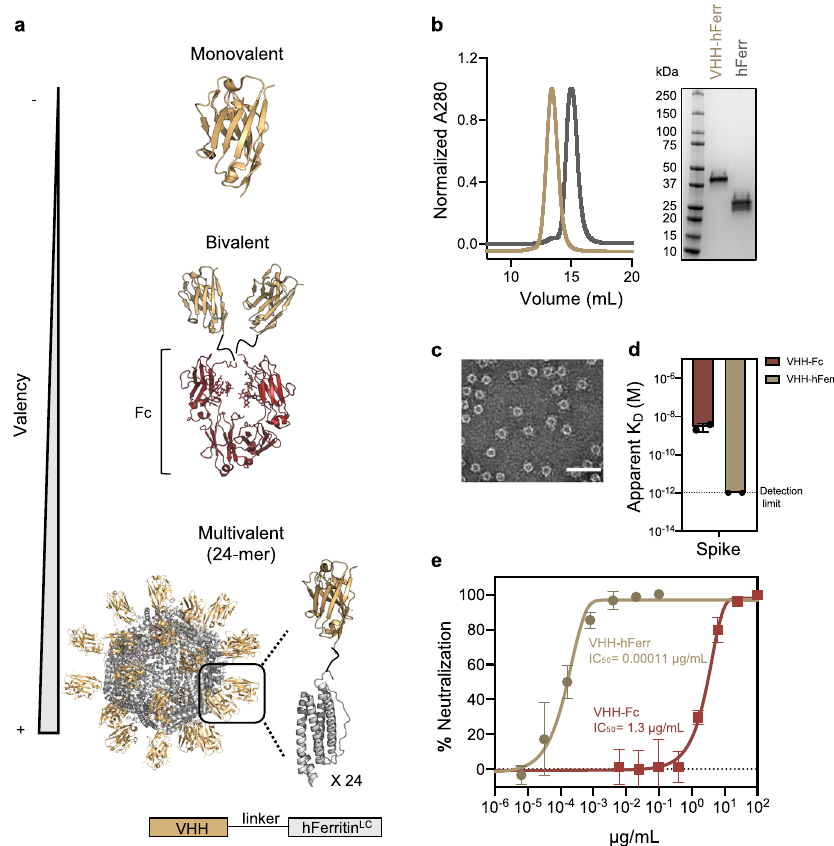
Fig. 1 Avidity enhances binding and neutralization of VHH against SARS-CoV-2. a Schematic representation of a monomeric VHH domain and its multimerization using a conventional Fc (dark red) scaffold or human apoferritin (gray). b Size exclusion chromatography and SDS-PAGE of apoferritin alone (gray) and VHH-72 apoferritin particles (gold). c Negative stain electron microscopy of VHH-72 apoferritin particles. (Scale bar 50 nm, representative of two independent experiments). d Comparison of the binding avidity (apparent K D ) of VHH-72 to SARS-CoV-2 S protein when displayed in a bivalent (dark red) or 24-mer (gold) format. Bars indicate the mean values of n = 2 biologically independent experiments. Apparent K D lower than 10 − 12 M (dash line) is beyond the instrument detection limit. e Neutralization potency against SARS-CoV-2 PsV (color coding is as in ( d )). One representative out of two biologically independent replicates with similar results is shown. Mean values ± SD of two technical replicates is represented in the plot. Median IC 50 values of the two biologically independent replicates are shown. Source data are provided as a Source Data fi